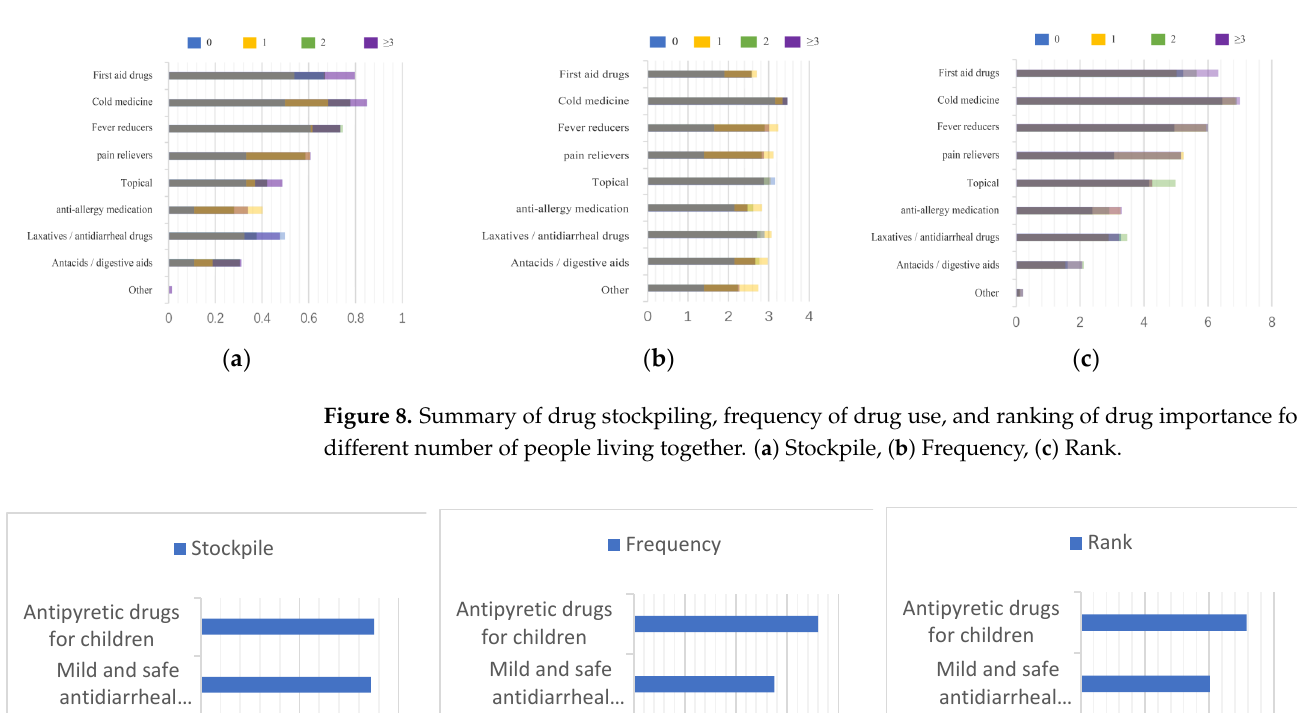
Figure 7. Summary of drug stockpiles, frequency of drug use, and ranking of drug importance in different regions. ( a ) Stockpile, ( b ) Frequency, ( c ) Rank.